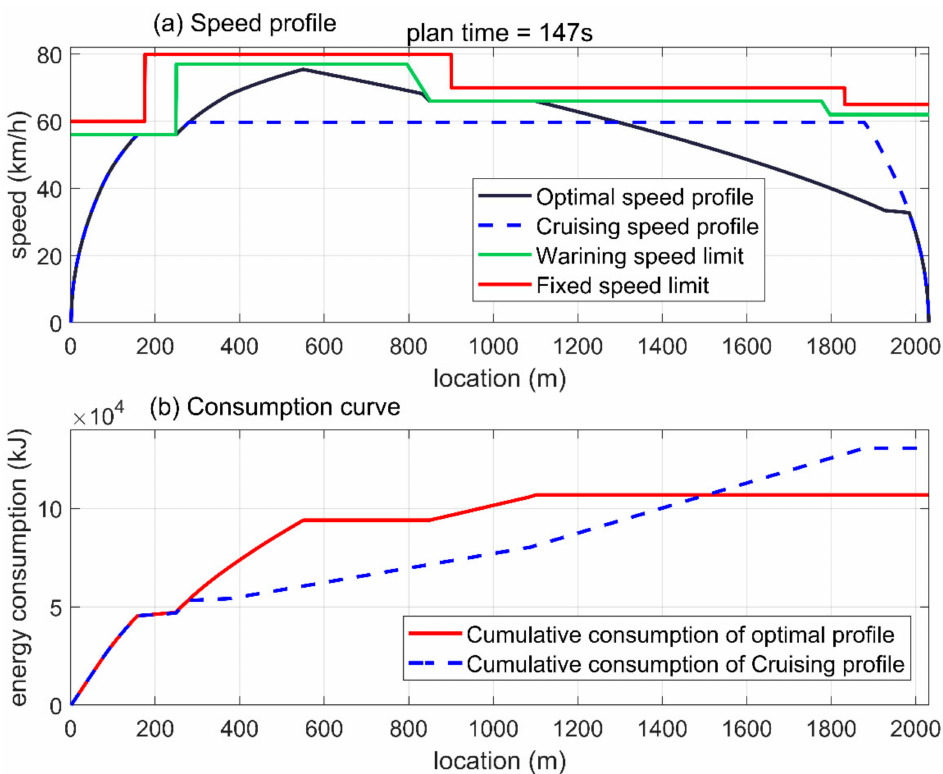
Figure 18. Comparison of di ff erent driving modes: ( a ) Comparison about coast mode and cruise mode in speed profile; ( b ) Comparison about coast mode and cruise mode in cumulative energy consumption curve.